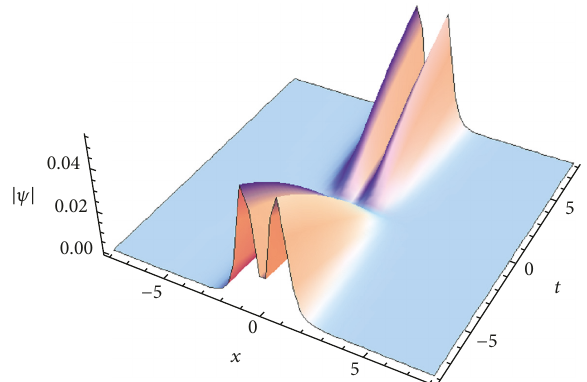
Figure 1: Spatial structure of the module of solution (20) with 𝑞 0 = 0.5 .